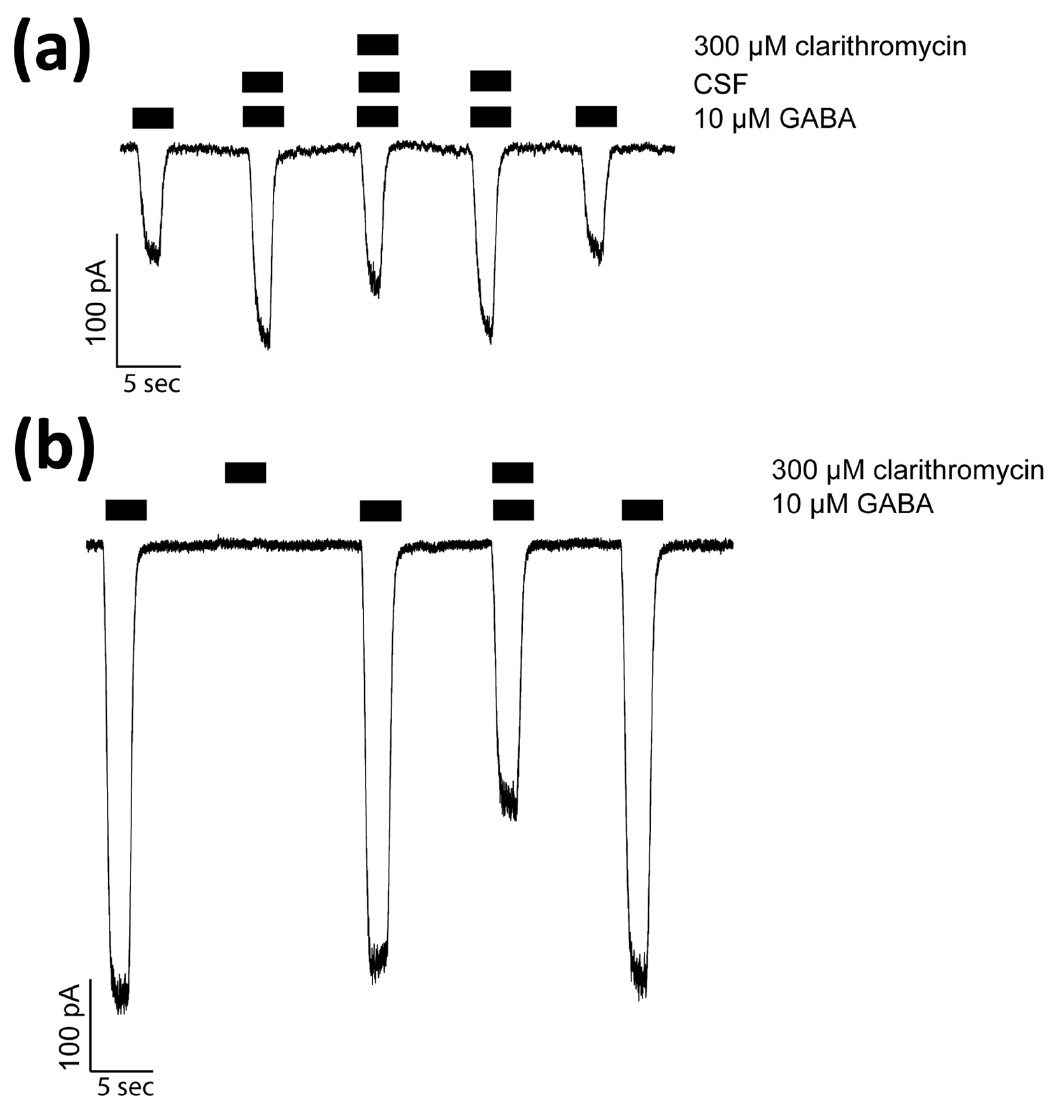
Figure 2. Clarithromycin inhibits CSF-mediated GABA receptor potentiation and activation. Whole cell voltage clamp recordings from HEK293 cells expressing α 1 β 2 γ 2s GABA A Rs. ( a ) CSF from a pa-